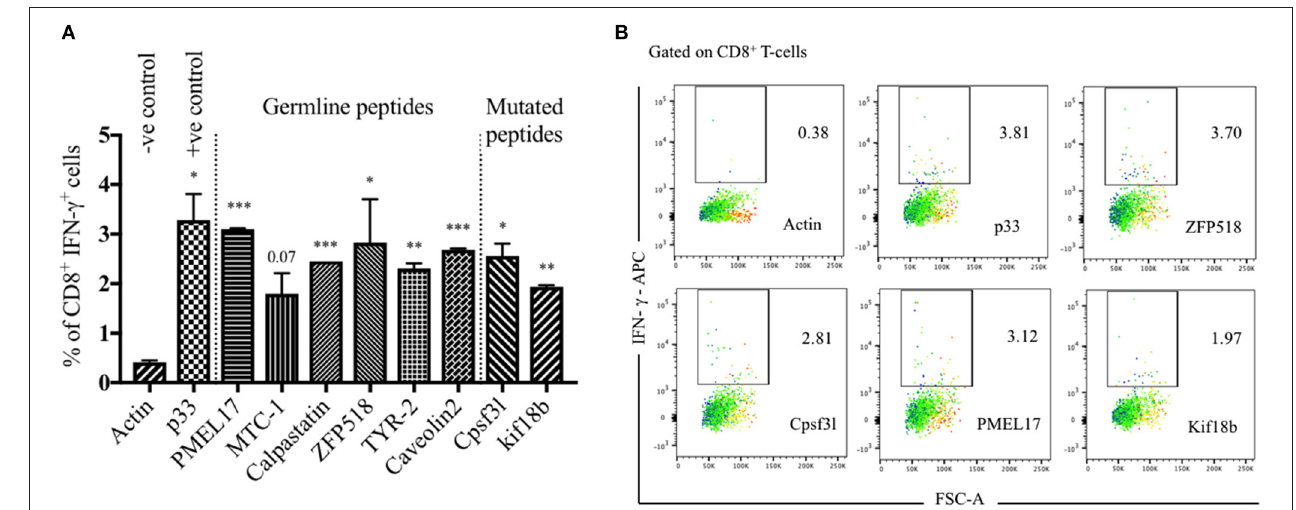
FIGURE 4 | Validation of germline and mutated epitopes identified by immunopeptidomics and predicted by whole exome sequencing. (A) Percentage of CD8 + IFN- γ + secreting cells (means ± SEM) in duplicate, pre-gated on TILs. p33 peptide was used as a positive control and actin as a negative control. Statistical analysis by Student’s t -test in comparison with Actin (–ve control). (B) Representative FACS plots showing the percentage of CD8 + IFN- γ + secreting cells pre-gated on TILs and stimulated with Actin (–ve control), p33 ( + ve control), ZFP518, Cpsf3l, PMEL17, and Kif18b peptides. One representative of 3 similar experiments is shown. * P < 0.05 ; ** P < 0.01 ; *** P < 0.001 ; **** P <